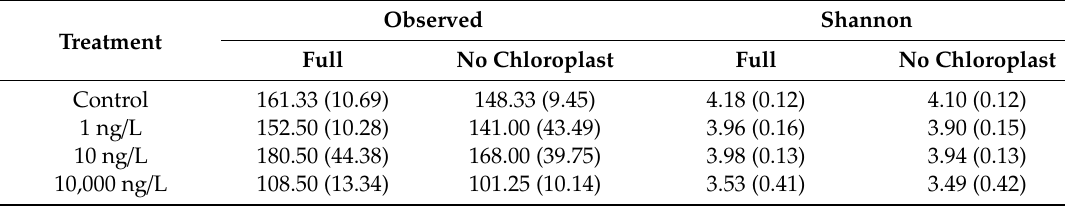
Table 1. Mean (s.d.) of alpha-diversity metrics under the effect of triclosan.